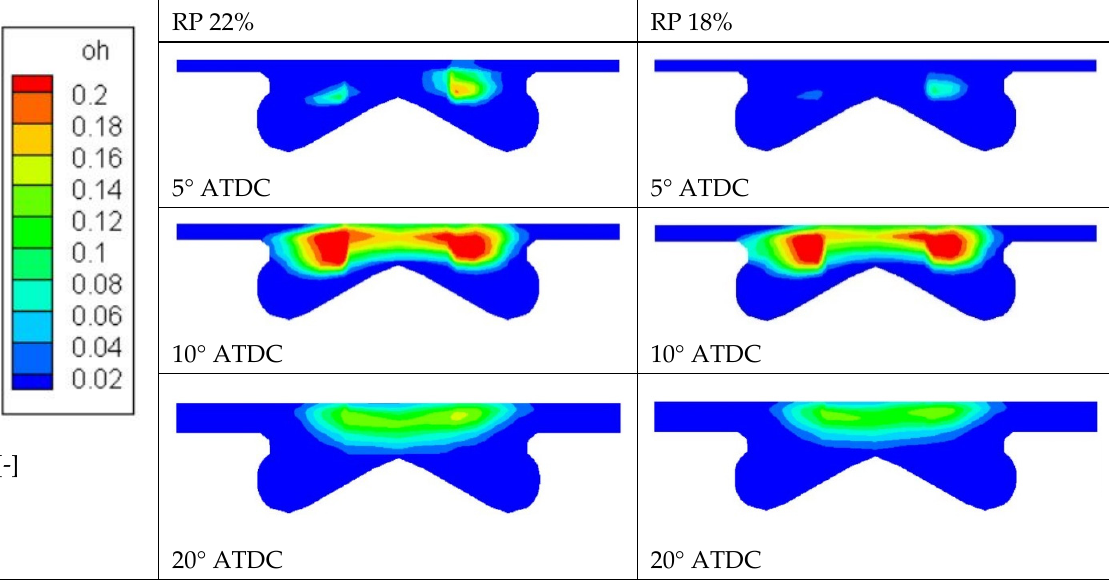
Figure 20. OH mass fraction contours for RP = 22 and 18% at 2000 rpm.